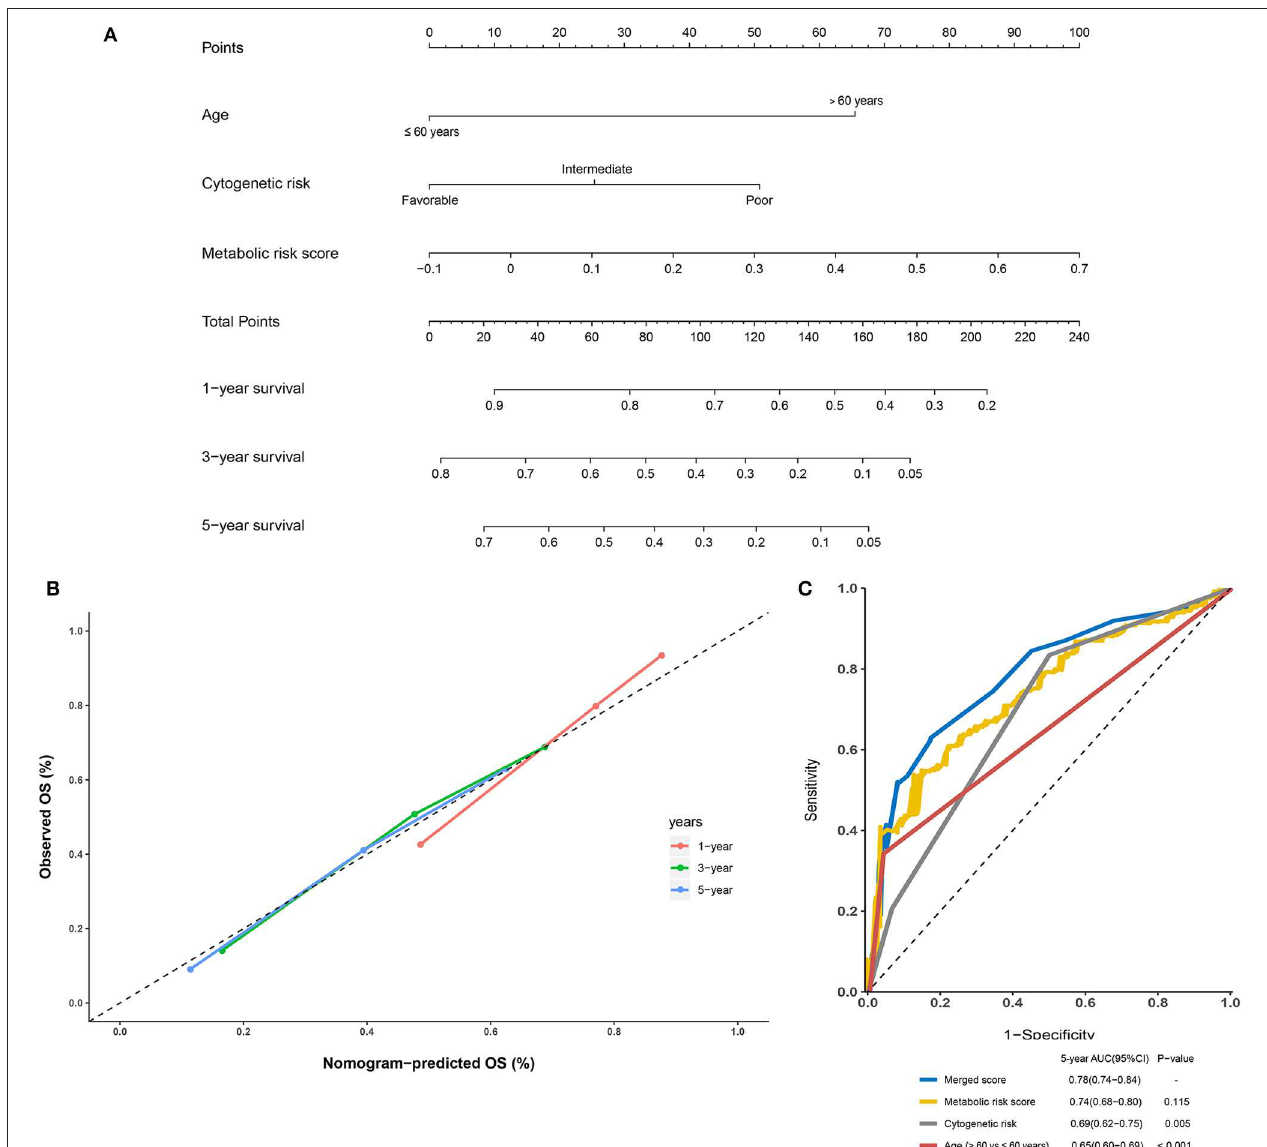
FIGURE 7 | Building and validation of the nomogram to predict the overall survival of patients with acute myelogenous leukemia (AML) combining the adult external cohort and pediatric external cohort. (A) Nomogram plot was built based on age, cytogenetics risk, metabolic risk score, and total points combining the adult external cohort and pediatric external cohort. (B) Calibration plot of the nomogram. (C) Time-dependent receiver operating characteristic (ROC) curves of nomograms were compared based on a 5-year OS of